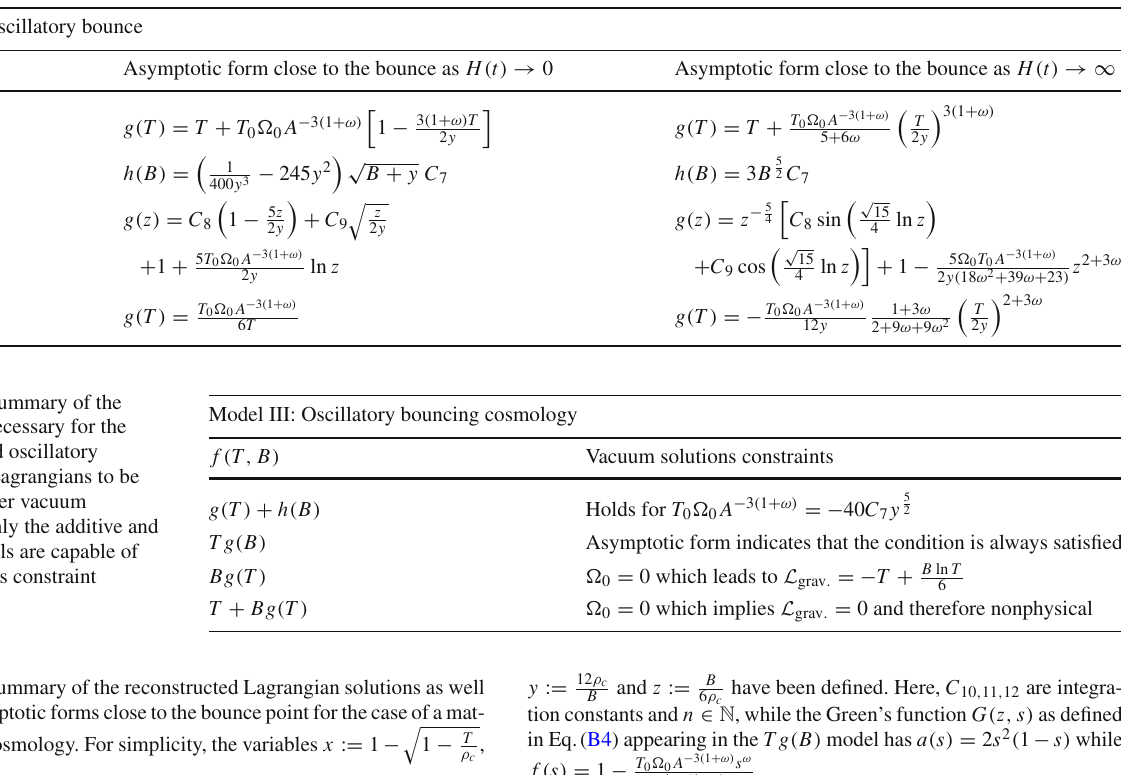
The homogeneous solution takes a complicated form. Only the asymp- totic form of the particular solu- tion is given: g part. ( z ) = 1